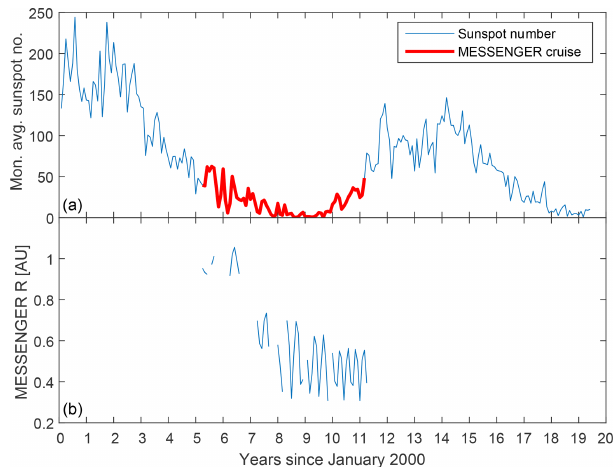
Figure 2. (a) Monthly average sunspot number in blue and the MESSENGER cruise phase in red. (b) The radial distance of MES- SENGER from the Sun during the cruise phase. The periods where no data are available are clearly